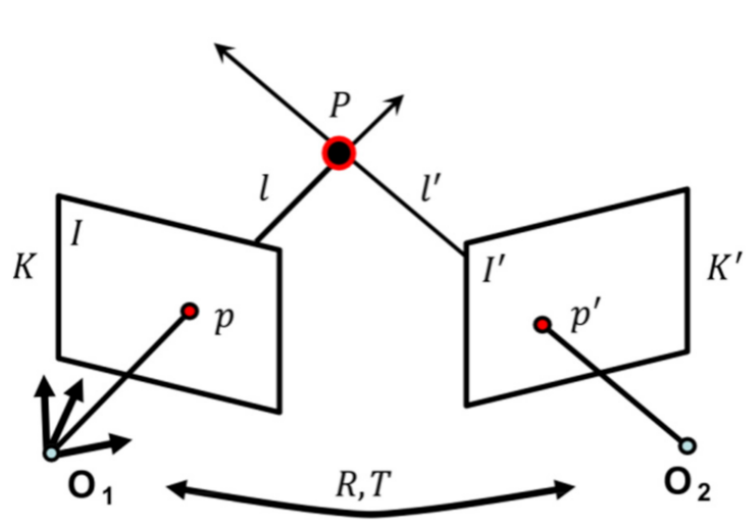
Figure 5. The parameter in the basic